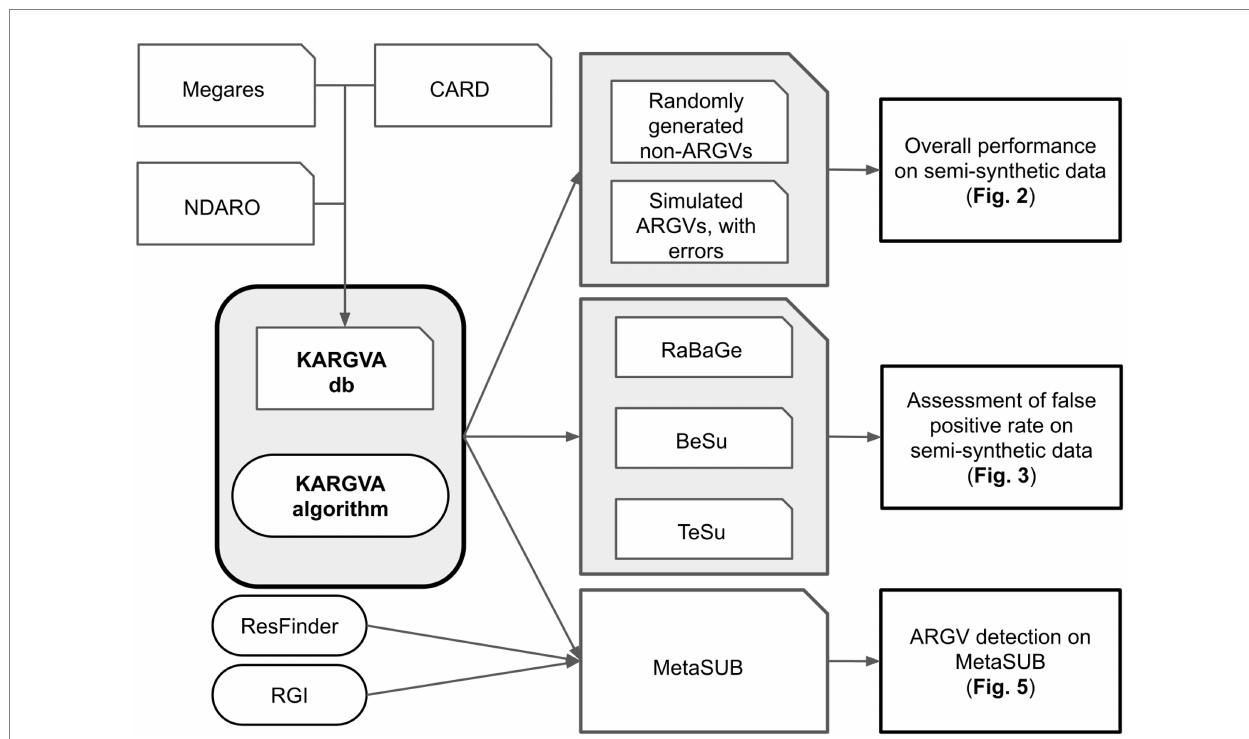
FIGURE 1 Development of KARGVA: The KARGVA database is collated from different sources. Benchmarks on semi-synthetic data: a first semi-synthetic dataset is used to benchmark KARGVA against randomly generated non-ARGVs and simulated ARGVs with errors; and three other semi-synthetic datasets are used to benchmark KARGVA against false positives. Evaluation on real metagenomics data: KAGVA is applied to real metagenomics data and the results are compared with existing ARGV prediction